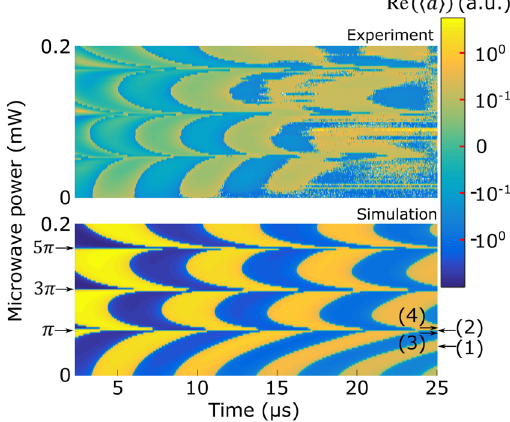
FIG. 6. Top: In-phase component (Re h ˆ a i ) of the pseudospin microwave emission during the FID experiment (time axis) plotted as a function of the rotation angle of the initial microwave pulse (microwave power axis). The signal intensity is plotted using a log color scale in order to emphasize the sign of the signal. The blue (yellow) colors correspond to negative (positive) signal intensities. Bottom: The corresponding FID simulations using the Maxwell-Bloch equations [Eq. (3)]. The rotation angles ( θ ¼ π , 3 π , 5 π ) indicated on the left correspond to the inverted state of the pseudospin j S; S i . The numbered arrows (1) – (4) shown on the right correspond to FID experiments shown separately in Fig. 7.